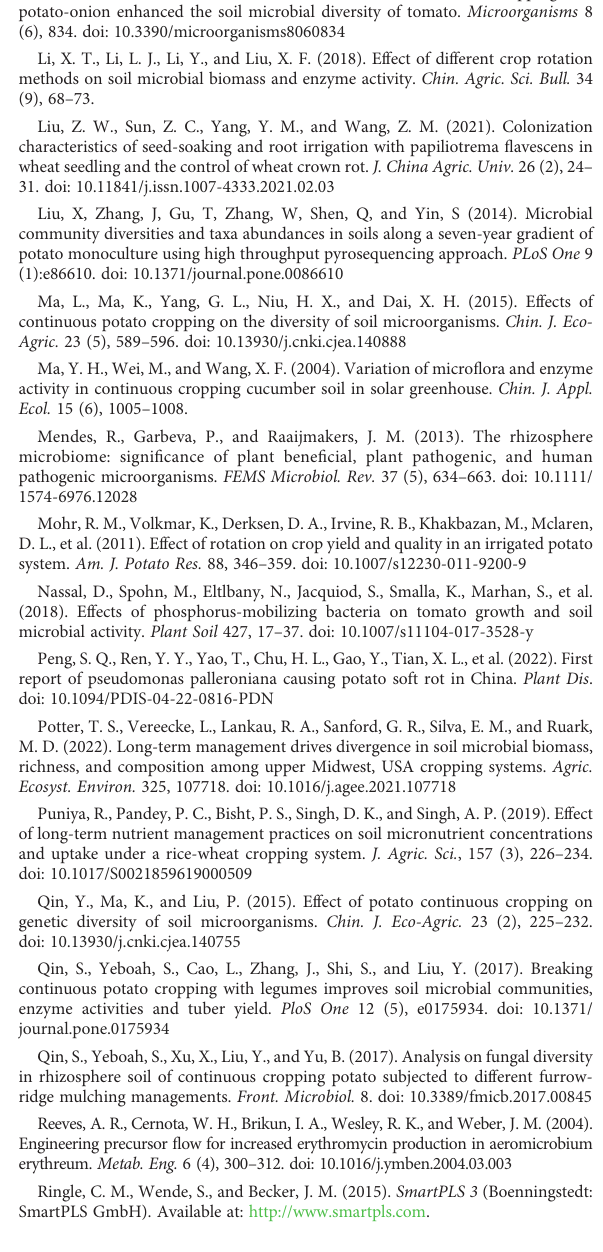
Correlation analysis of soil biochemical properties and the dominant bacterial (A) and fungal (B) genera. * and ** indicate signi fi cant differences between two indices at P < 0.05 and P < 0.01 level, respectively. ALP, alkaline phosphatase; ACP, acid phosphatase; SUC, sucrase; URE, urease; AP, available phosphorus; AK, available potassium; AN, available